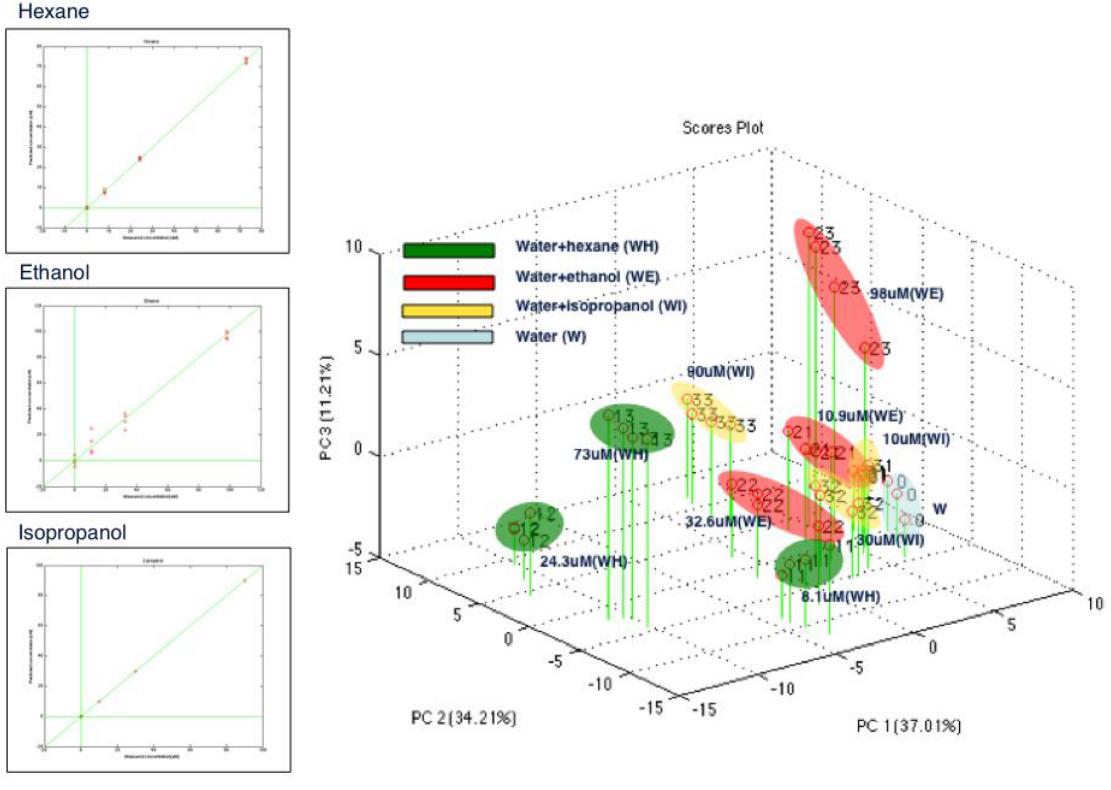
Figure 7. The liquid sensors have been calibrated to different solutions of water with addition of hexane, ethanol, isopropanol ( Left ). The score plot obtained by the principal component analysis model shows a discrimination of the mixtures ( Right